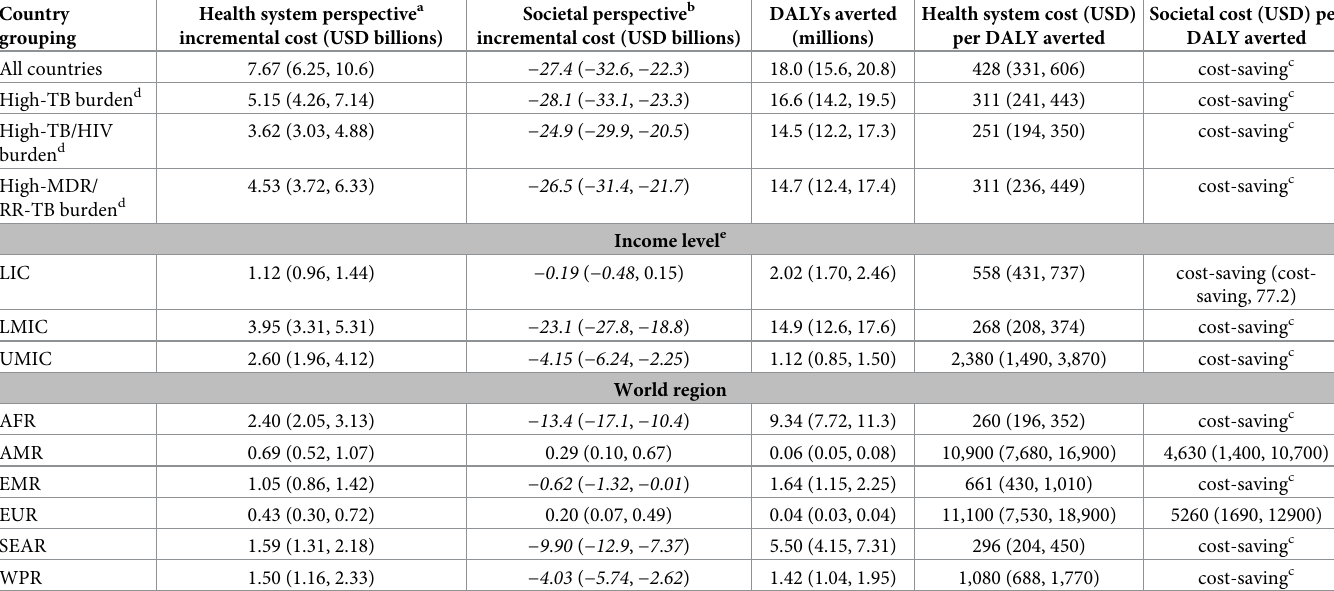
Table 2. Discounted costs, DALYs averted, and cost-effectiveness of infant tuberculosis